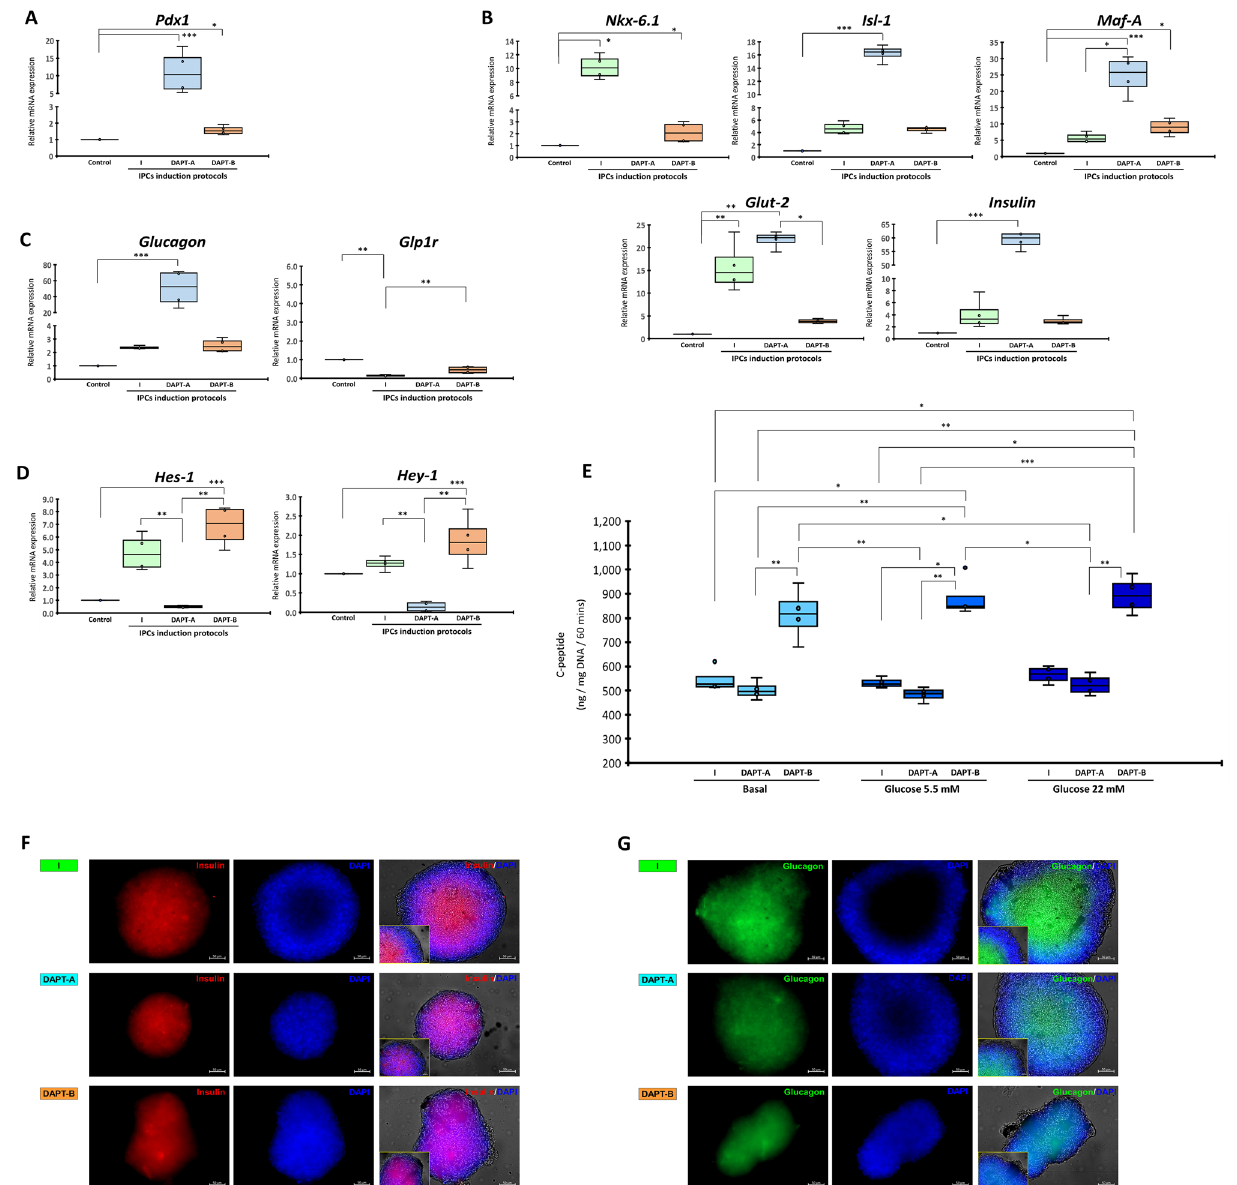
Figure 7. Generation of cAD-MSC-derived IPCs with Notch signaling manipulation. mRNA markers relating to pancreatic endoderm ( A ), pancreatic beta-cell ( B ), pancreatic-relating markers ( C ), and Notch target genes ( D ) were analyzed by RT-qPCR. mRNA expression was normalized with a reference gene and undifferentiated control. Functional testing by glucose-stimulated C-peptide secretion (GSCS) is illustrated in ( E ). Insulin ( F ) and Glucagon ( G ) protein expression were evaluated by immunocytochemistry staining. The results were observed under fluorescent microscope ZEISS Apotome.2 (Carl Zeiss, Germany) incorporated with Axio Observer Z1 and ZEN pro software (ZEISS International, Germany). Bars indicate a significant difference (*, p value < 0.05; **, p < 0.01; ***, p <